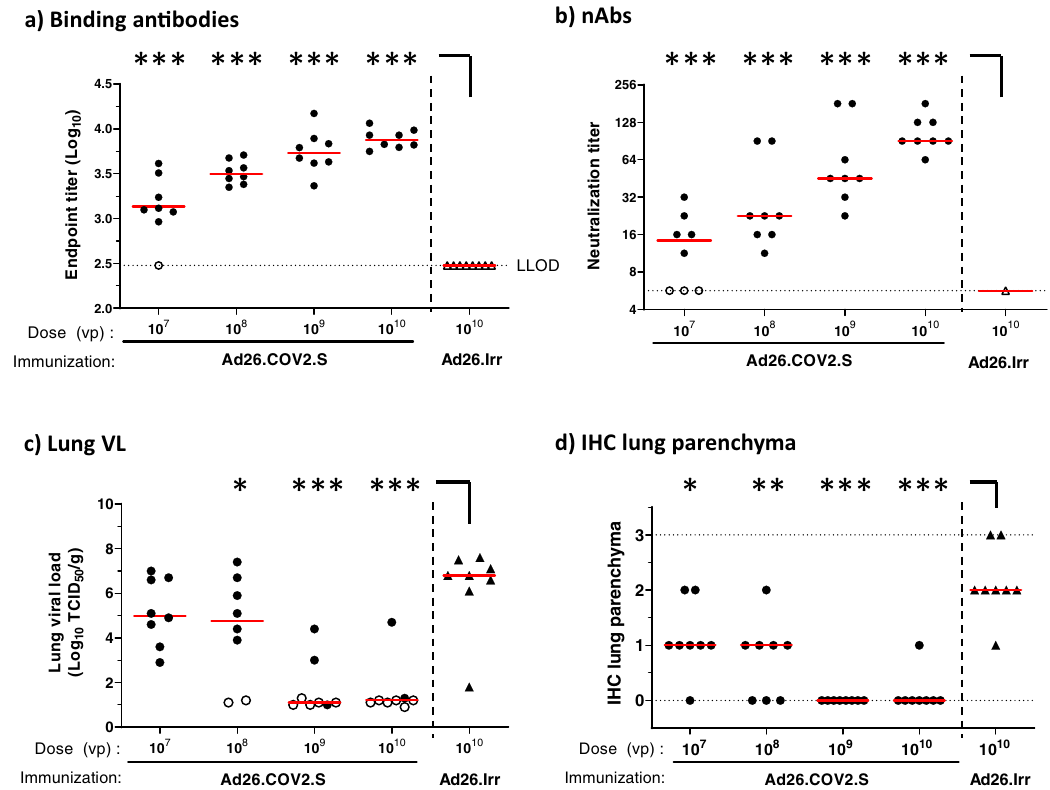
Fig. 4 Dose responsiveness of Ad26.COV2.S on immunogenicity and lung viral load in hamsters. Syrian hamsters were intramuscularly immunized with 10 7 , 10 8 , 10 9 , or 10 10 VP of Ad26.COV2.S N = 8 per group, or 10 10 VP Ad26.Irr (an Ad26 vector not encoding any SARS-CoV-2 antigens, N = 8). Four weeks after one immunization, SARS-CoV-2 Spike protein-speci fi c antibody-binding titers as measured by ELISA ( a ) and SARS-CoV-2-neutralizing antibodies as measured by wtVNA ( b ) were determined. The median antibody responses per group is indicated with a horizontal line. Dotted lines indicate the LLOD. Animals with a response at or below the LLOD were put on LLOD and are shown as open symbols. Hamsters received intranasal inoculation with 10 2 TCID 50 SARS-CoV-2 strain BetaCoV/Munich/BavPat1/2020 4 weeks post immunization (week 4). Right lung tissue was isolated 4 days after inoculation for virological analysis and immunohistochemistry. c Lung viral load was determined by TCID 50 assay on Vero E6 cells. The median viral load per group is indicated with a horizontal line. LLOD was calculated per animal, and animals with a response at or below the LLOD are shown as open symbols. d The presence of SARS-CoV-2 NP was determined by immunohistochemical staining. Comparisons were performed between the Ad26.COV2.S dose level groups, with the Ad26.Irr group by Mann – Whitney U test. Statistical differences indicated by asterisks: * p < 0.05; ** p < 0.01; *** p < 0.001. Ad26.Irr Ad26 vector not encoding any SARS-CoV-2 antigens, LLOD lower limit of detection, N number of animals, TCID 50 /g 50% tissue culture infective dose per gram tissue, VP virus particles, NP nucleocapsid protein, wtVNA wild-type virus neutralization